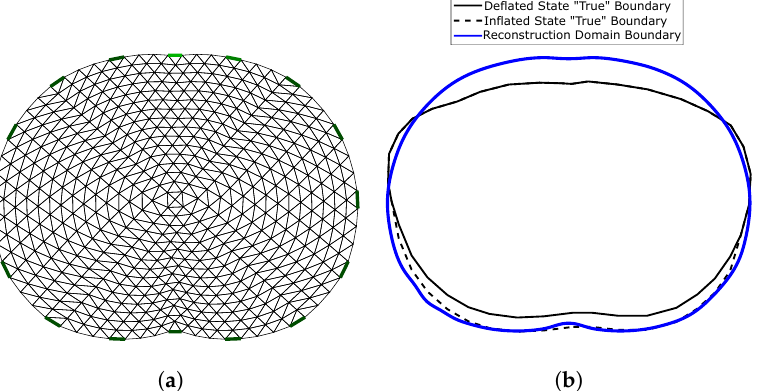
Figure 6. ( a ) 2D reconstruction thoracic domain ( Ω ). ( b ) Shape mismatch between the “true” cross- section model and Ω